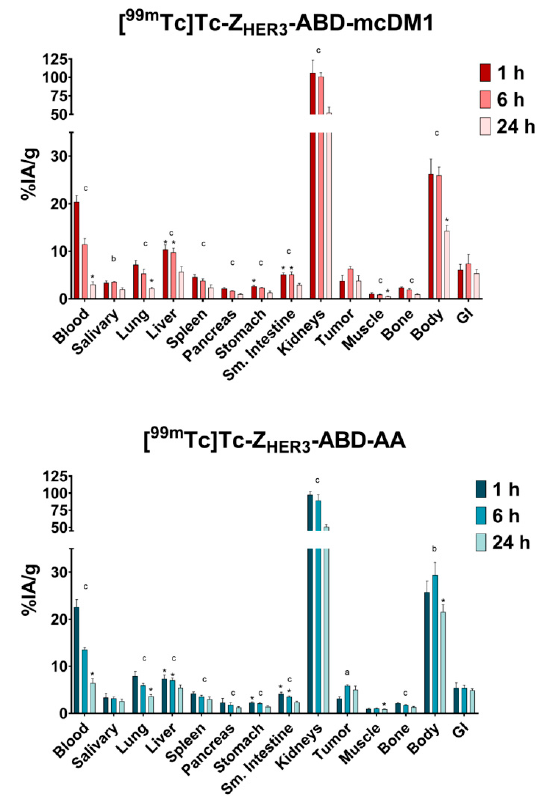
Figure 7. General biodistribution of [ 99m Tc]Tc-Z HER3 -ABD-mcDM1 and [ 99m Tc]Tc-Z HER3 -ABD-AA. Analyses were performed at 1 h, 6 h, and 24 h pi in mice bearing BxPC-3-derived xenografts. The bars represent the average of four mice. Data are presented as the uptake in different organs as a percentage of the injected activity divided by the weight of the organ or tumor (%IA/g). The data for the GI tract and body are presented as %IA per whole sample. Each mouse received an injection of 20 µ g of the [ 99m Tc]Tc-labeled conjugates. * corresponds to statistically significant differences ( p < 0.05) between [ 99m Tc]Tc-Z HER3 -ABD-mcDM1 and [ 99m Tc]Tc-Z HER3 -ABD-AA for the same organ at the same time-point. a corresponds to significant differences ( p < 0.05) between the 1 and 6 h time points. b corresponds to significant differences ( p < 0.05) between the 6 h and 24 h time points. c corresponds to significant differences ( p < 0.05) between the 1 h and 24 h time